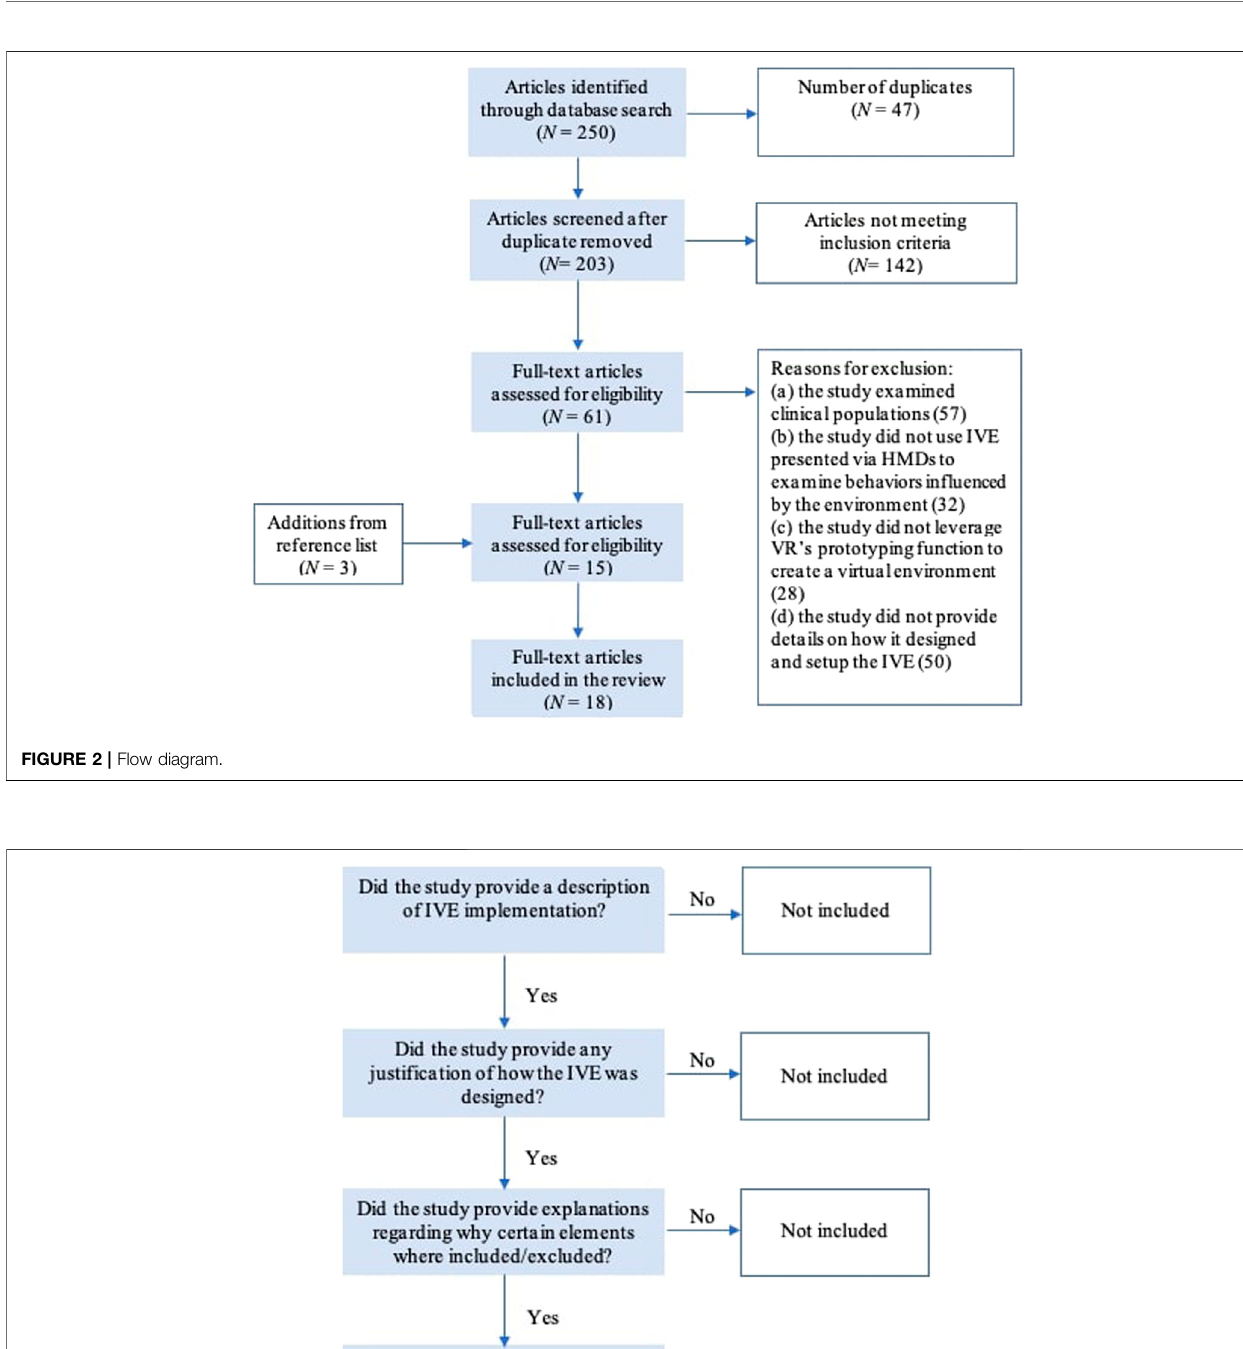
Frontiers in Virtual Reality |